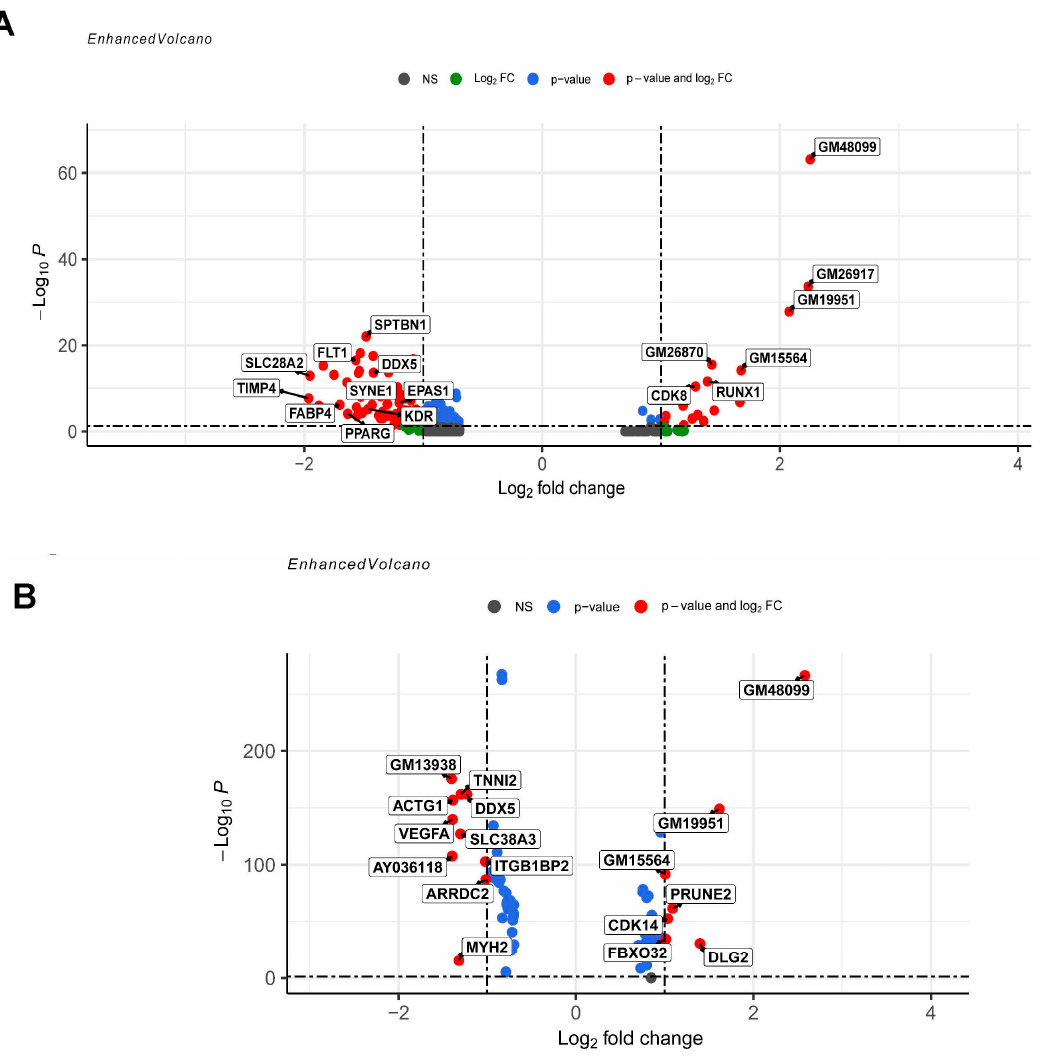
Figure 2. Differential gene expression in ECs and SKMs from DMD mut versus control muscles. ( A ) Differential gene expression in ECs from DMD mut versus control muscles. Volcano plots were used to show the adjusted p values and log2 fold change values of the genes in ECs from DMD mut and wild-type control muscles. Differentially expressed genes (DEGs), represented by red dots, were defined as genes with an adjusted p value of ≤ 0.05 and a log2 fold change value of greater than 0.26 in magnitude. Square symbols were used to indicate upregulated genes (such as GM48099, GM26917, GM19951, GM26870, GM15564, RUNX1, and CDK8) and a downregulated gene (such as SPTBN1). ( B ) Differential gene expression in SKMs from DMD mut versus control muscles. Volcano plots were used to show the adjusted p values and log2 fold change values of the genes in SKMs from DMD mut and wild-type muscles. DEGs, represented by red dots, were defined as genes with an adjusted p value of ≤ 0.05 and a log2 fold change value of greater than 0.26 in magnitude. Square symbols were used to indicate upregulated genes (such as GM48099, GM19951, GM15564, PRUNE2, CDK14, et al.) and downregulated genes (such as TNNI2, DDX5, VEGFA, MYH2, ITGB1BP2, SLC38A3, et